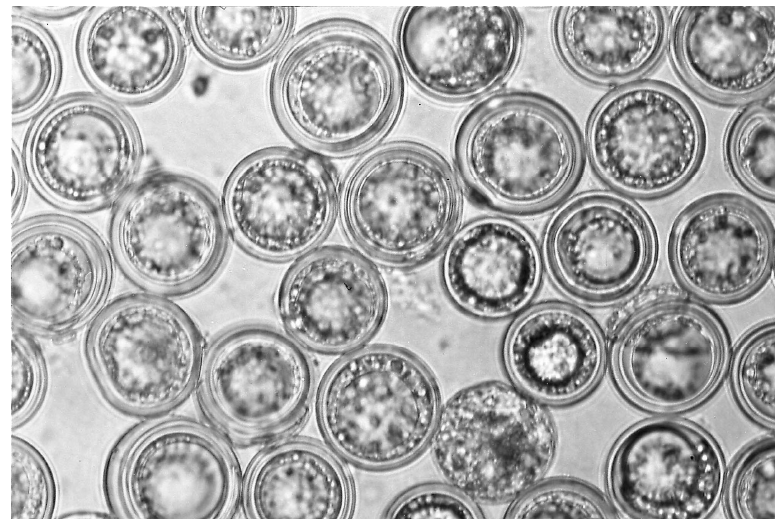
Figure 3. Resting spores (azygospores) of E. maimaiga that were formed within later instar gypsy moth larvae ( Lymantria dispar ) killed by this fungus, and which fill the cadaver (~30–32 μ m diameter). The thick walls and regular shape of dormant resting spores are visually attractive (i.e., sleeping beauties); this form of resting spore is not atypical among fungi in the Entomophthoromycotina.